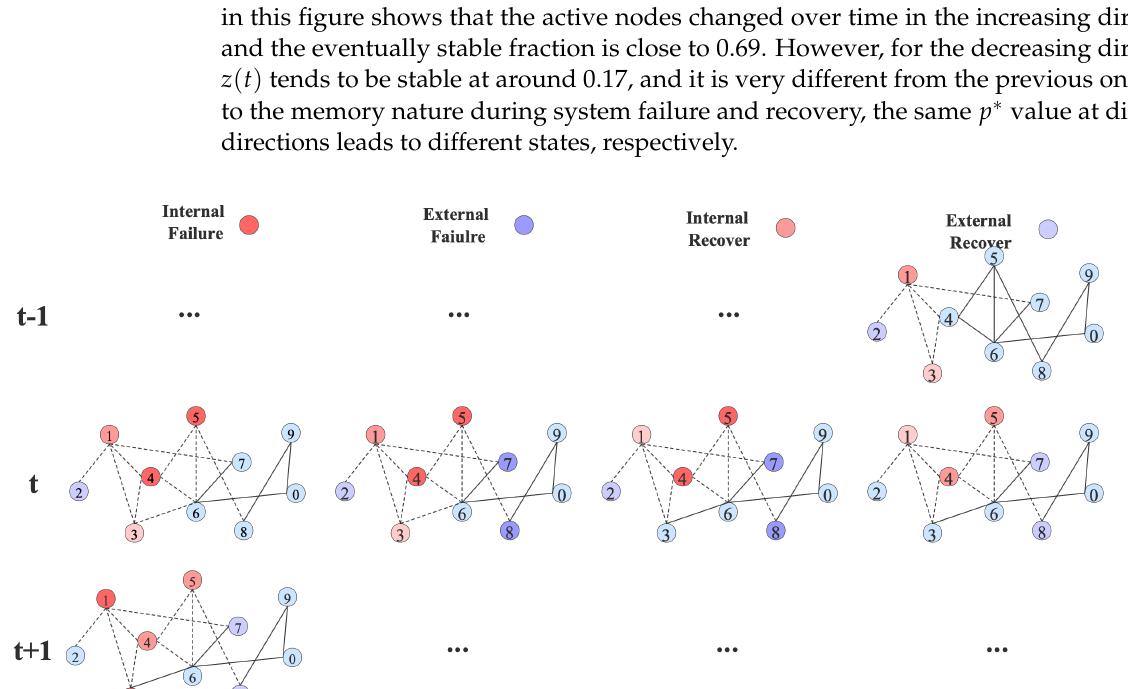
Figure 1. Schematic illustration of the dynamic recovery process under an LA. At time t − 1, after these four steps, the network changed into the fourth network in the first row. Nodes 1 and 3 are suffering internal failure, but node 3 has recovered one time ( l = 1), while node 1 just internally failed the last time ( l = 0). Additionally, node 2 is suffering an external failure ( l = 0). At time t , nodes 4 and 5 are chosen to internally fail, and then nodes 7 and 8 only have one active neighbour, so they externally fail. Node 1, which internally fails at time t − 1, can recover one time ( l = 1), and node 3 has achieved l = 2 = τ , so it can be active again, and the edge between nodes 3 and 6 can also be active. Finally, node 2 reaches the time required for external recovery, and it becomes active ( l = 1 = τ (cid:48) ). Next time, two nodes will be locally chosen again, and the node still belonging to the internal failure state can fail again, such as node 1 in the first network in the third row since its l changed to 0 again. Then, the process occurs repeatedly.